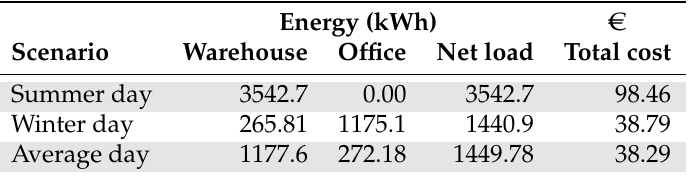
Table 6. Results for the business-as-usual case for three temperature scenarios in the Netherlands.